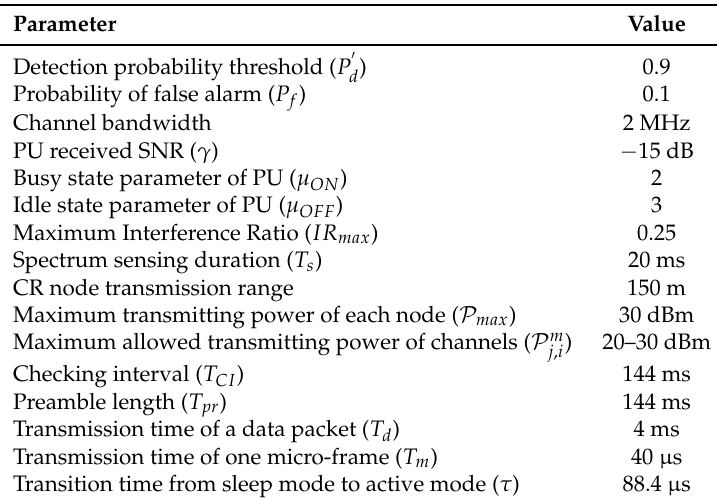
Figure 3. Sample simulated topology with Poisson distributed nodes (density = 400 nodes per square kilometers). The filled squares and dotted circles represent the location and coverage area of PU transmitters, respectively. Table 1. Simulation Configuration